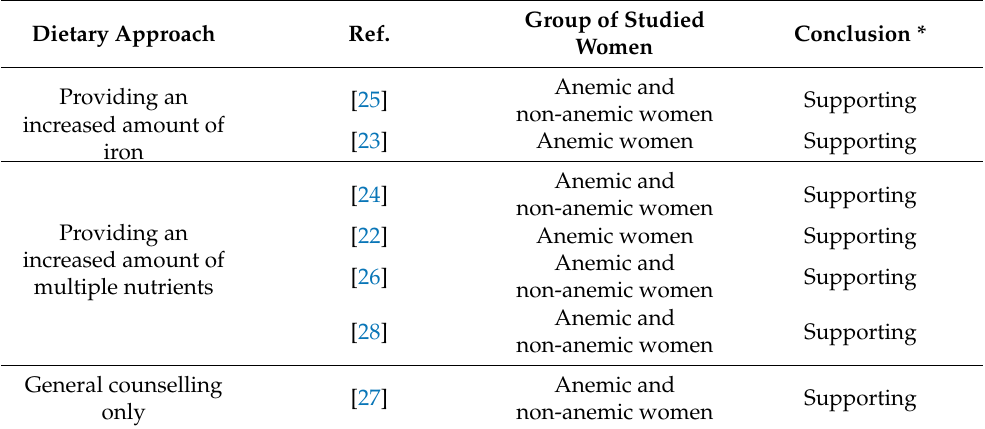
Table 7. The summary of conclusions formulated within the randomized controlled trials included in the systematic review [22–28].